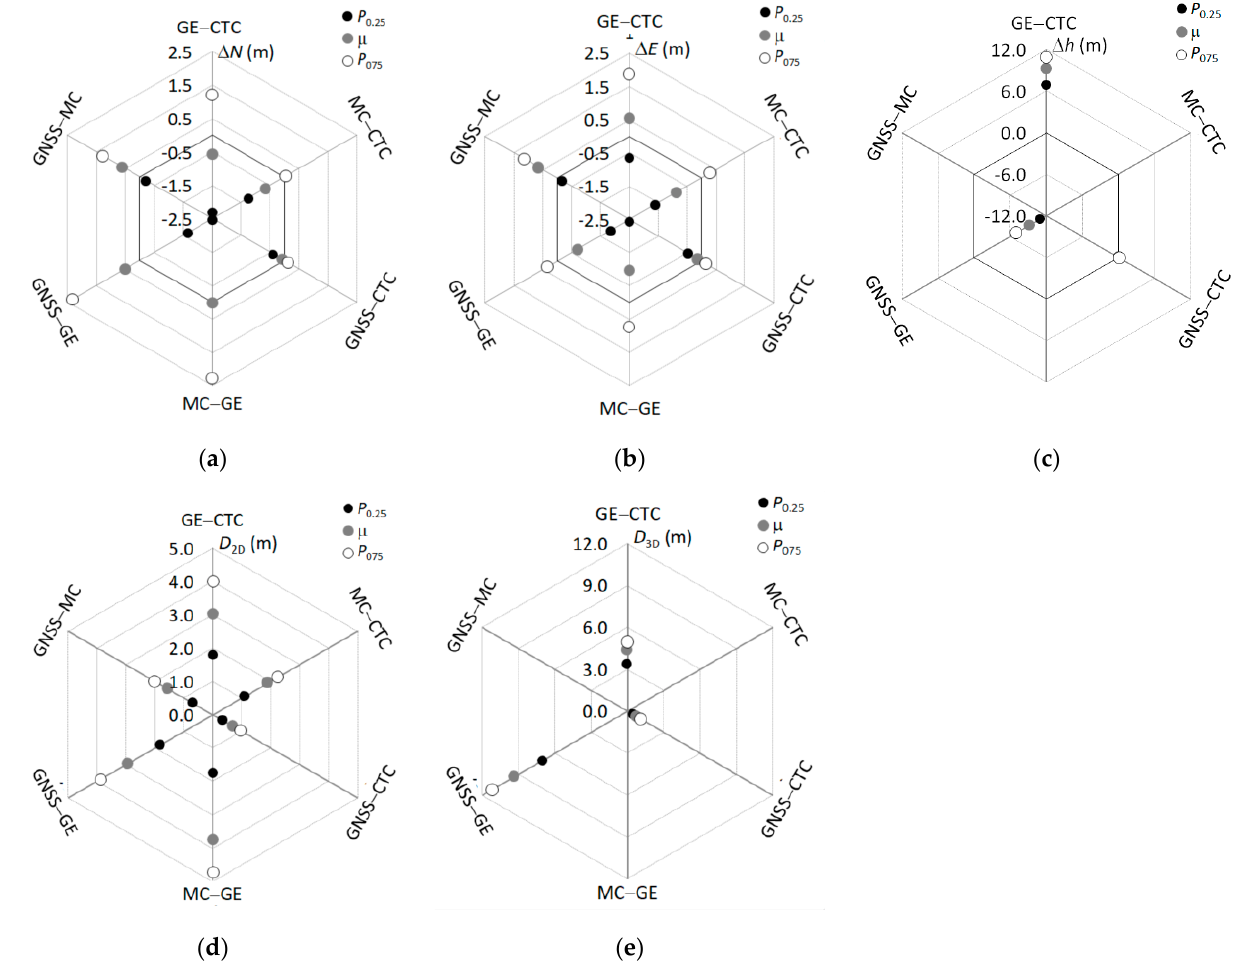
Figure 8. I quartile, average, and III quartiles of the coordinate difference ( P 025 , μ , and P 025 , respec- tively) of the components: ( a ) Δ N , ( b ) Δ E , and ( c ) Δ h , and of the planimetric and plano-altimetric differences: ( d ) D 2D and ( e ) D 3D , respectively). Values are evaluated after outliers’ removal.